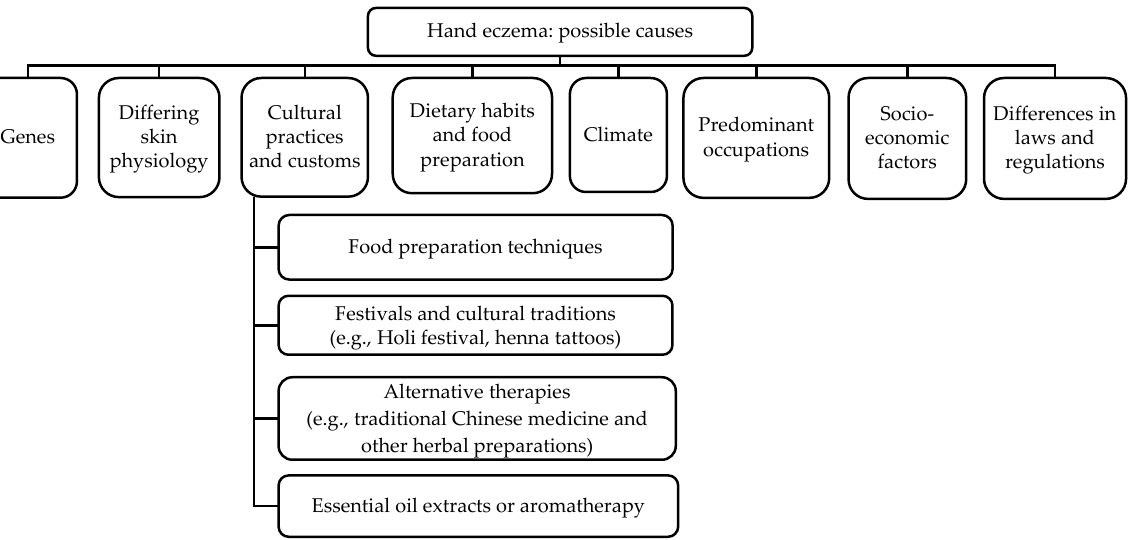
Figure 1. Possible causes of hand eczema across different ethnicities.